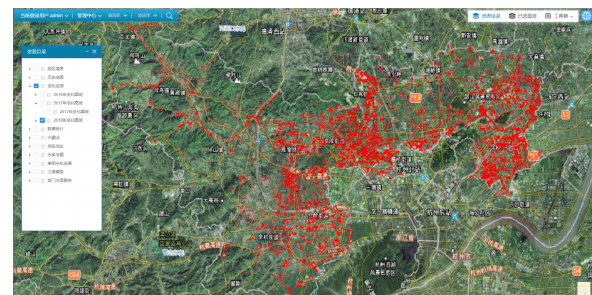
Fig.9 Unban Space Change Monitoring Result for